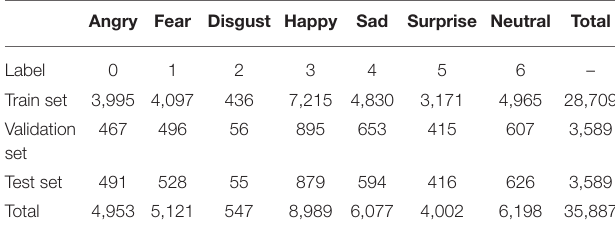
TABLE 1 | Data distribution of FER2013 dataset.